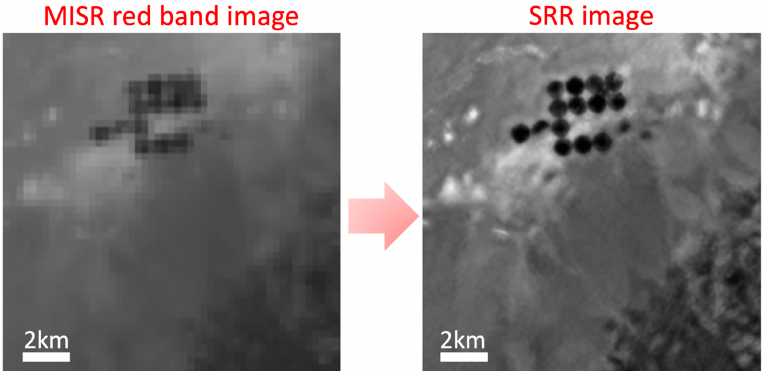
Figure 1. An example of the 275 m Multi-angle Imaging SpectroRadiometer (MISR) red band image ( left ) super-resolved to 68.75 m super-resolution restoration (SRR) image ( right